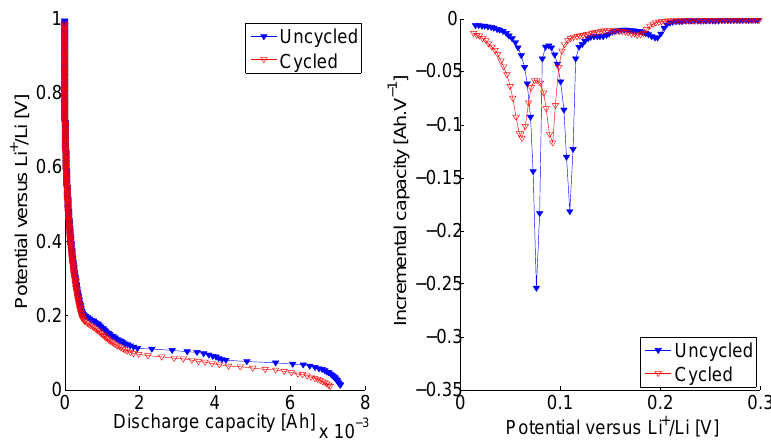
Figure 5. ( Left ) Graphite potential versus discharge capacity; ( Right ) Graphite incremental capacity during lithiation processes.